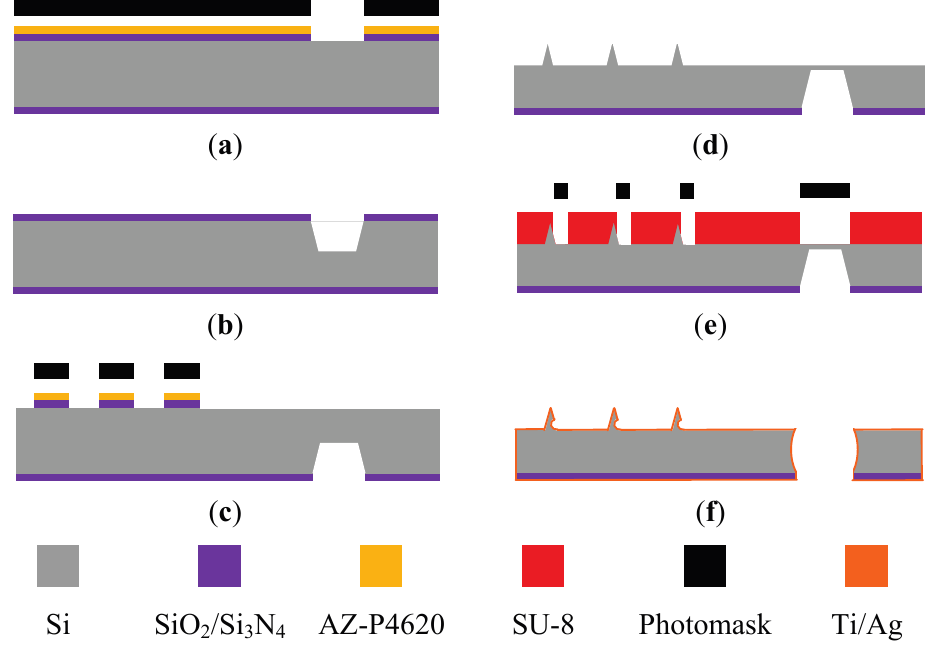
Figure 4. Barbed microtip array fabrication processes.